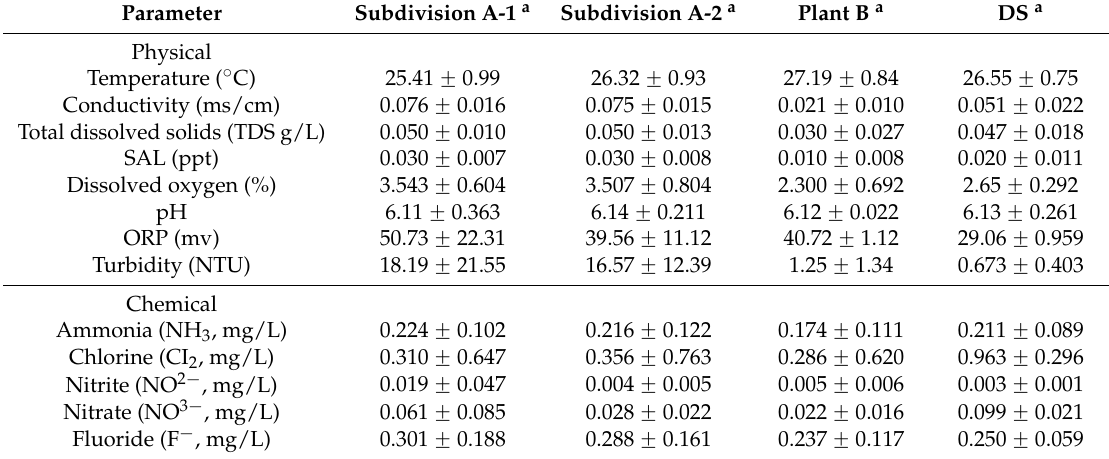
Table 4. Physical and chemical parameters of each treatment plant and the distribution systems. Parameter Subdivision A-1